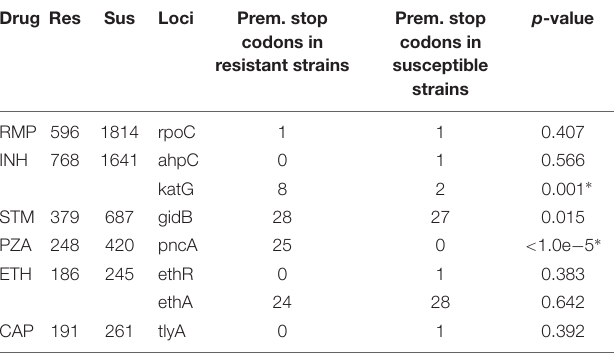
TABLE 7 | Occurrence of resistance-associated genes with premature stop codons found in resistant or susceptible strains in the validation data set. Drug Res Sus